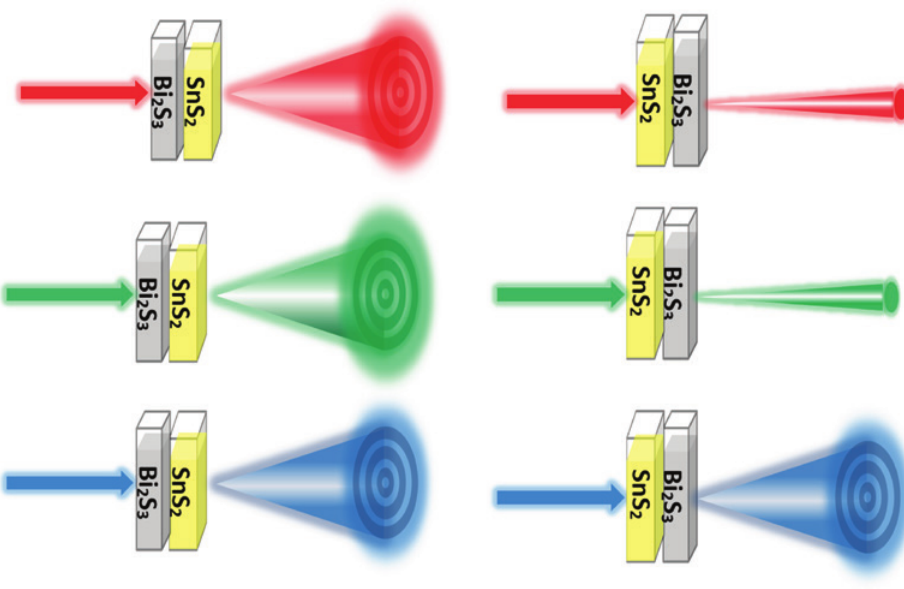
S /SnS with λ = 457 nm, λ = 532 nm, and λ = 671 2 3 2